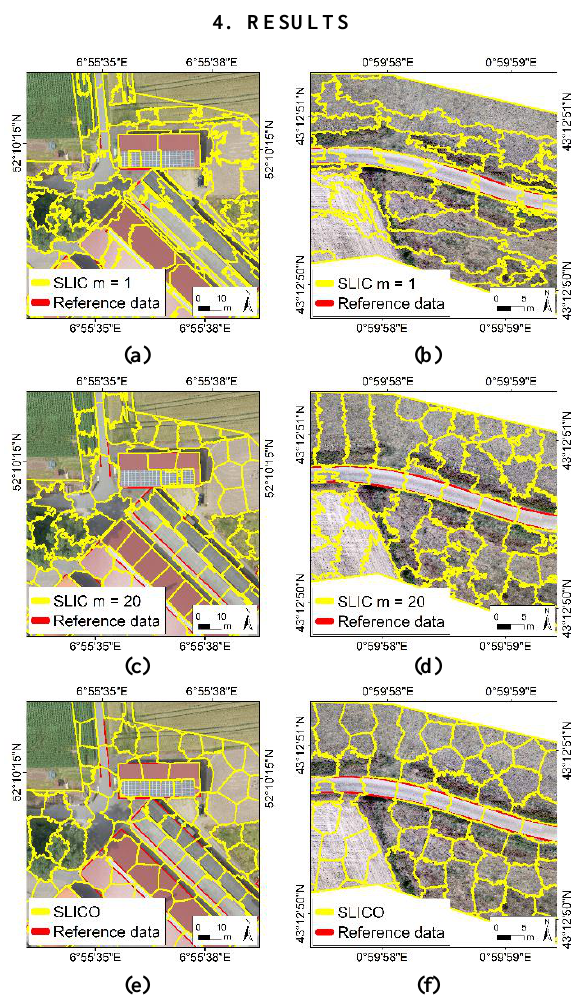
Figure 3. SLIC outlines derived for compactness parameters ( a, b ) m = 1, ( c, d ) m = 20, and ( e, f ) SLICO, where m is adaptively refined for each superpixel. The first row of images shows superpixels overlaid on the orthoimage of Amtsvenn, while the second row shows superpixels overlaid on the orthoimage of Toulouse, both for k = 10,000.